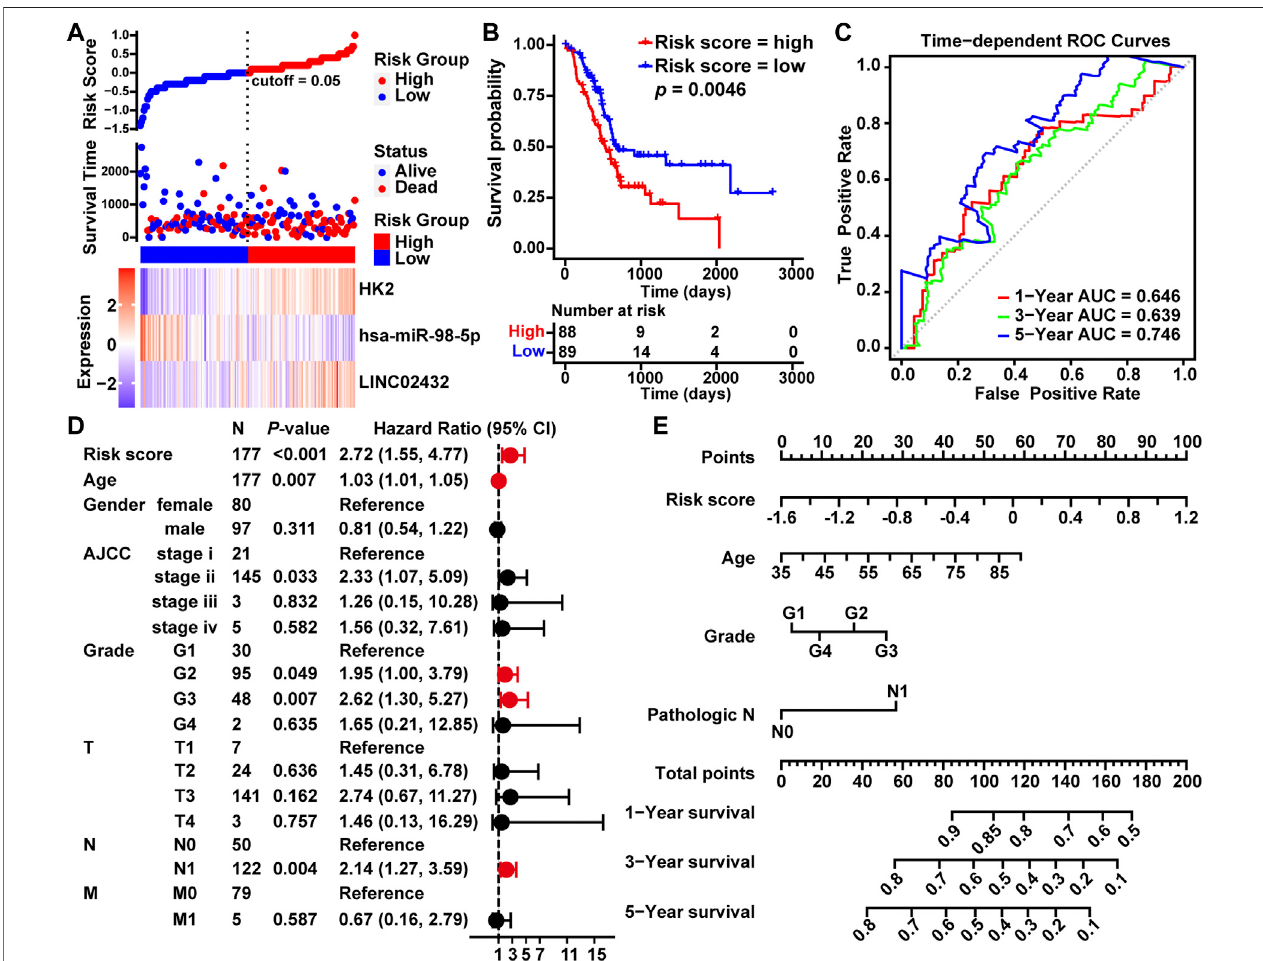
FIGURE 3 | Construction of a prognostic model of PAAD based on the LINC02432/hsa-miR-98 – 5p/HK2 ceRNA network. (A) Risk curves and scatter plots for each sample in the TCGA-PAAD cohort after rearrangement by the ggrisk algorithm. The heat map exhibited the expression levels of LINC02432, hsa-miR-98 – 5p, and HK2 inthehighriskscoreandlowriskscoregroups. (B) Kaplan-Meier analysisshowingoverallsurvivalinlow-risk andhigh-riskpatientgroups. (C) Thetime-dependent ROC curves and AUC for 1-year, 3-years, and 5-years overall survival. (D) Univariate Cox regression analysis was used to assess the association of clinicopathological features and risk scores. (E) A nomogram model was constructed using four independent prognostic factors (risk score, age, grade, and pathological T).